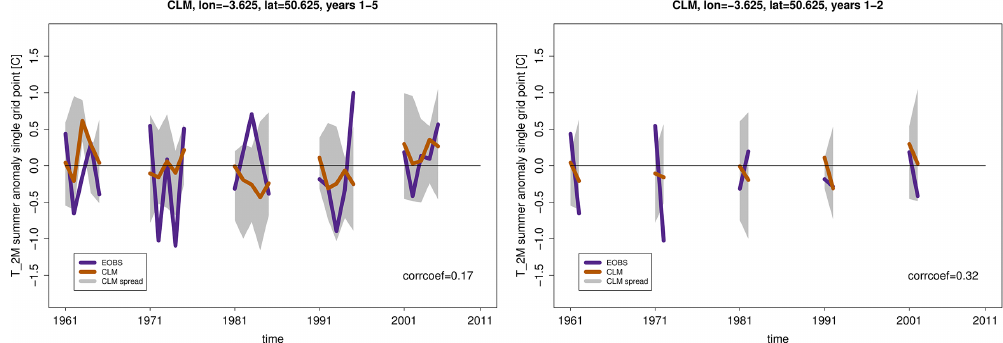
Figure 10. Summer temperatures at a grid point near Exeter in South England. Left: Lead years 1–5. Right: Lead years